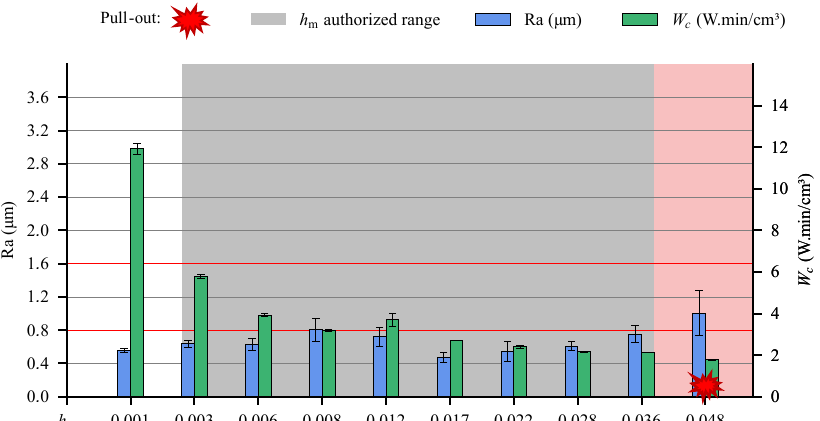
3401 mm/min, respectively.